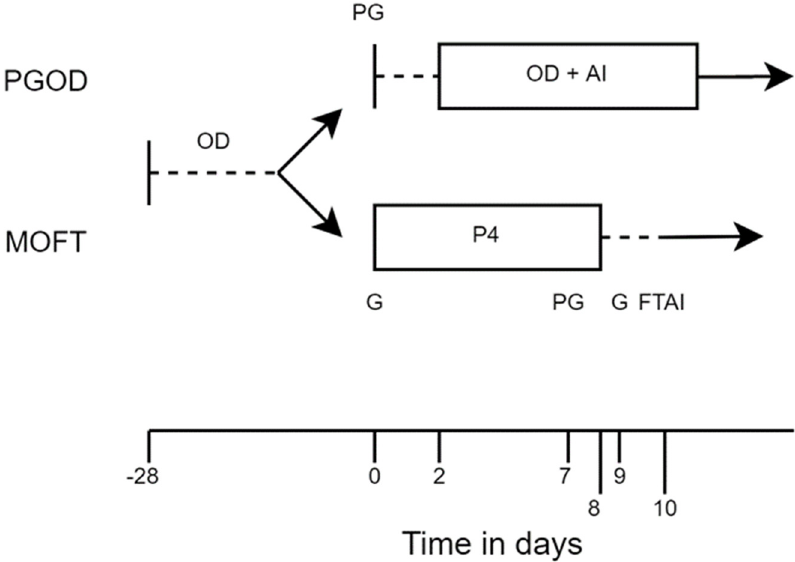
Figure 1. Experimental design of a randomized trial to compare the effect of two different treatment protocols (i) PGOD: 0.15 mg d-cloprostenol sodium (PG) intramuscularly at day 0 and insemination (AI) following observed estrus (OD) from day 2 onwards; (ii) MOFT: 100 µ g of gonadorelin acetate (G) intramuscularly and an intravaginal device containing 1.38 g progesterone (P4) at day 0, 0.15 mg d-cloprostenol sodium intramuscularly at day 7, removal of the intravaginal device at day 8 and 100 µ g of gonadorelin acetate intramuscularly at day 9, 24 h after device removal. Fixed time artificial insemination (FTAI) took place 54 ± 6 h after device removal (10.25 ± 0.25 days); administered to cows not observed in estrus for 28 days prior mating start date at mating start date (day 0).